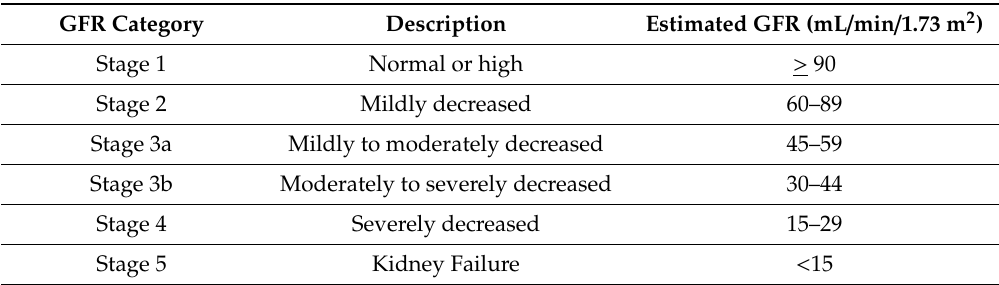
Table 1. The stages of chronic kidney disease (CKD) by glomerular filtration rate (GFR)